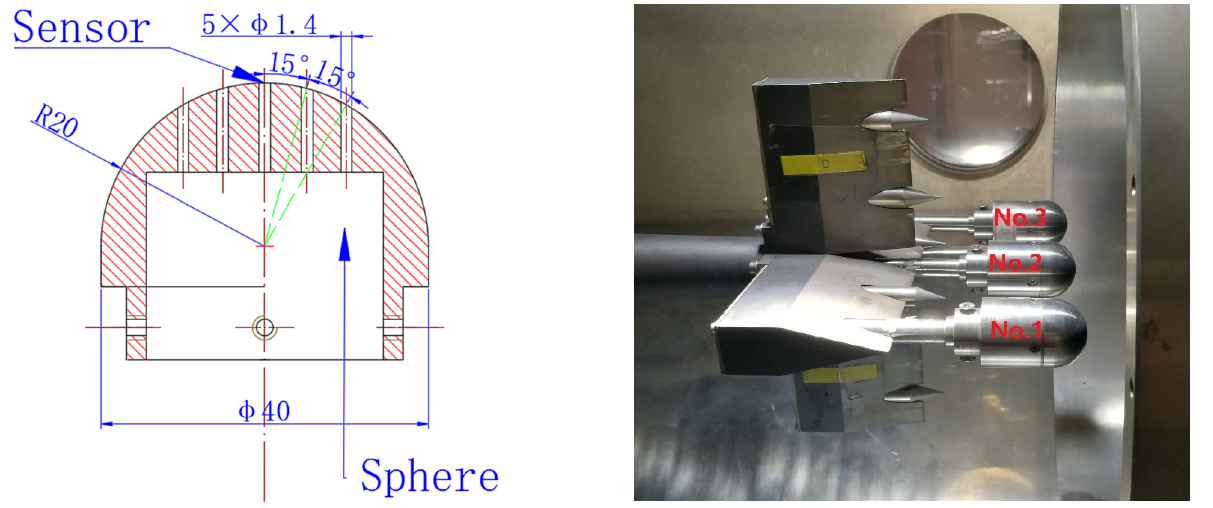
Figure 4. Sphere model ( left ) and installation diagram ( right ).